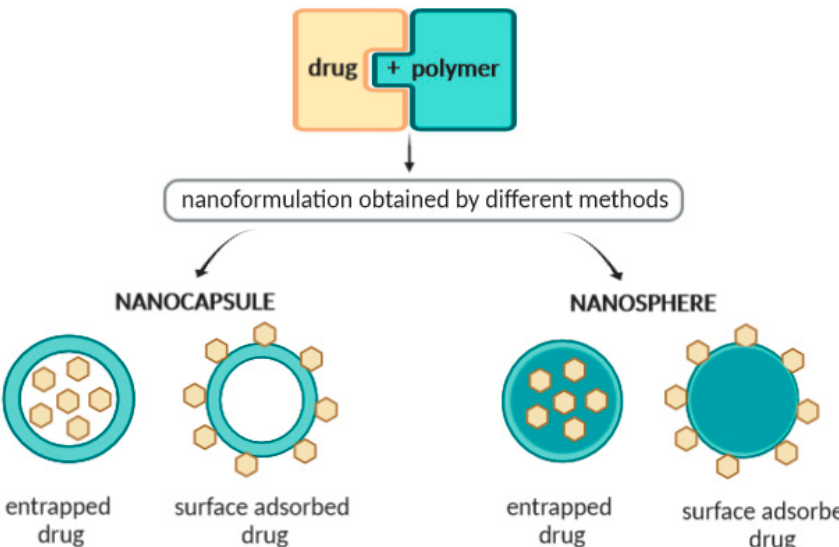
Figure 6. Di ff erent possibilities of the drug association with nanospheres and Figure 6. Different possibilities of the drug association with nanospheres and nanocapsules.